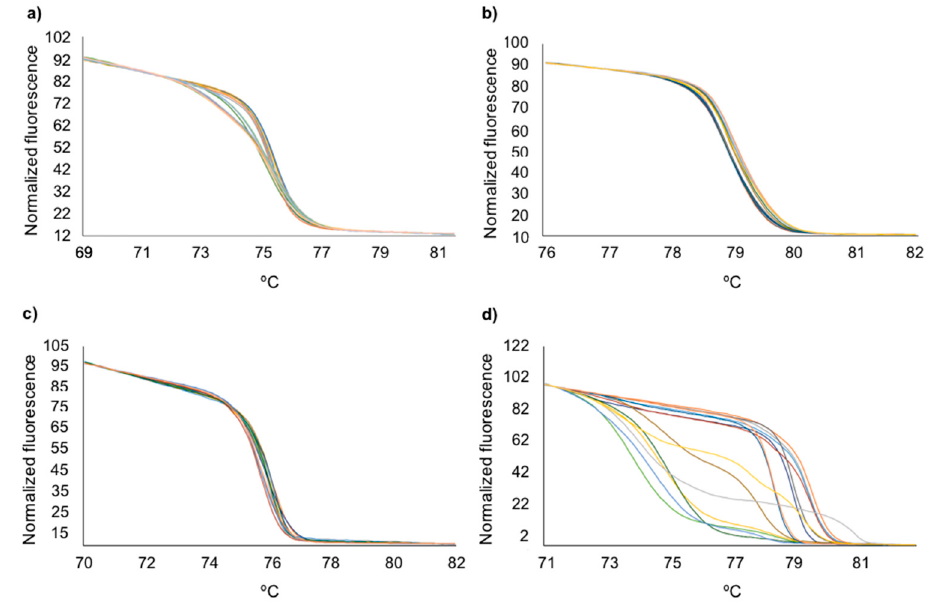
Figure 2. High resolution melting pattern types assessment for wheat chromosome 4A ISBP markers. Normalized HRM curves for 19 samples were shown for ( a ) marker HRM4A_67413676 (pattern type